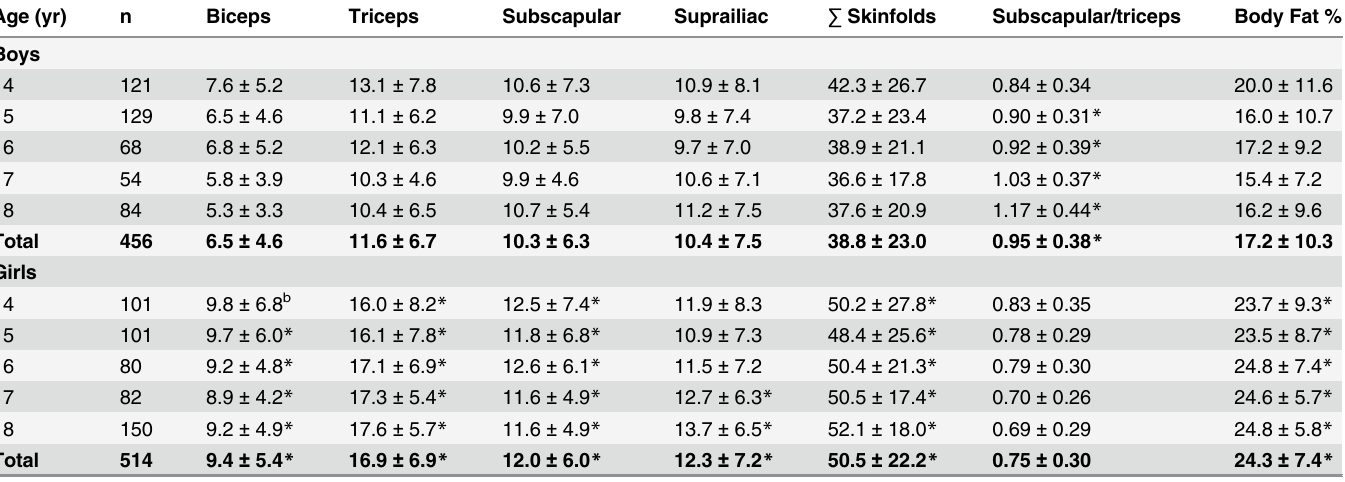
Table 2. Mean values ( ± SD) of skinfold thickness and percentage body fat in male and female Polish adolescents aged 14 – 18. Age (yr) n